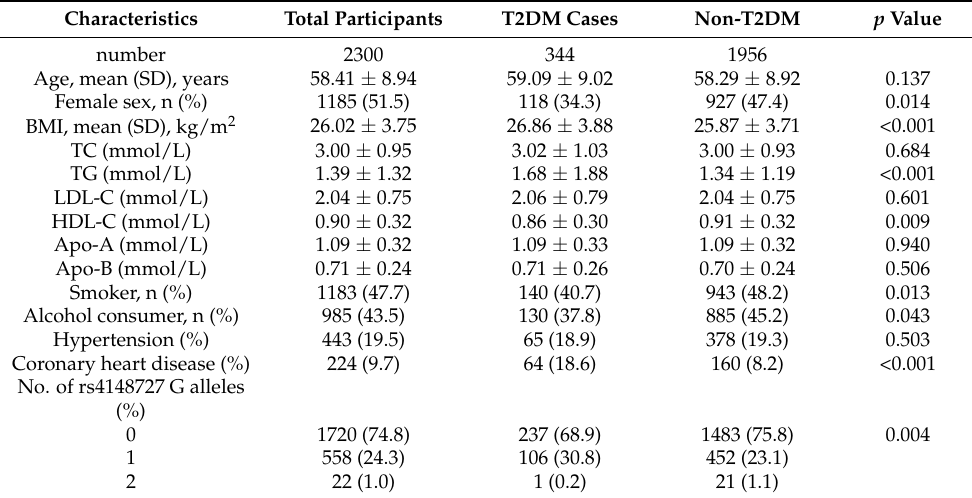
Table 1. Baseline characteristics of newly diagnosed patients with type 2 diabetes (T2DM).